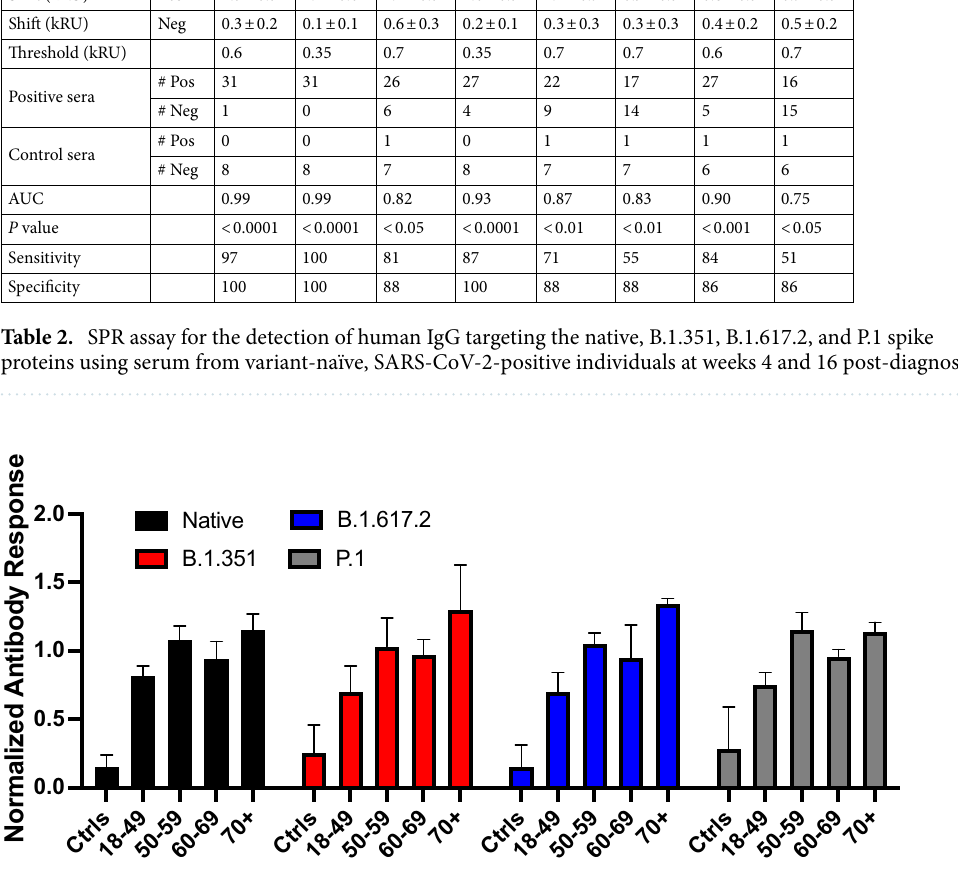
Figure 2. Average normalized antibody binding stratified by age group for human anti-IgGs targeting the native (black), B.1.351 (red), B.1.617.2 (blue) and P.1 (gray) spike proteins among variant-naïve, non- hospitalized individuals. SPR and ELISA data from weeks 4 and 16 post-diagnosis were normalized to the mean of the overall cohort and pooled. A normalized antibody binding of 1 thus refers to a response equivalent to the average of all SARS-CoV-2-positive individuals (n = 8 for each data set) and the error bars correspond to one standard deviation). Ctrls: SARS-CoV-2-negative sera (n =